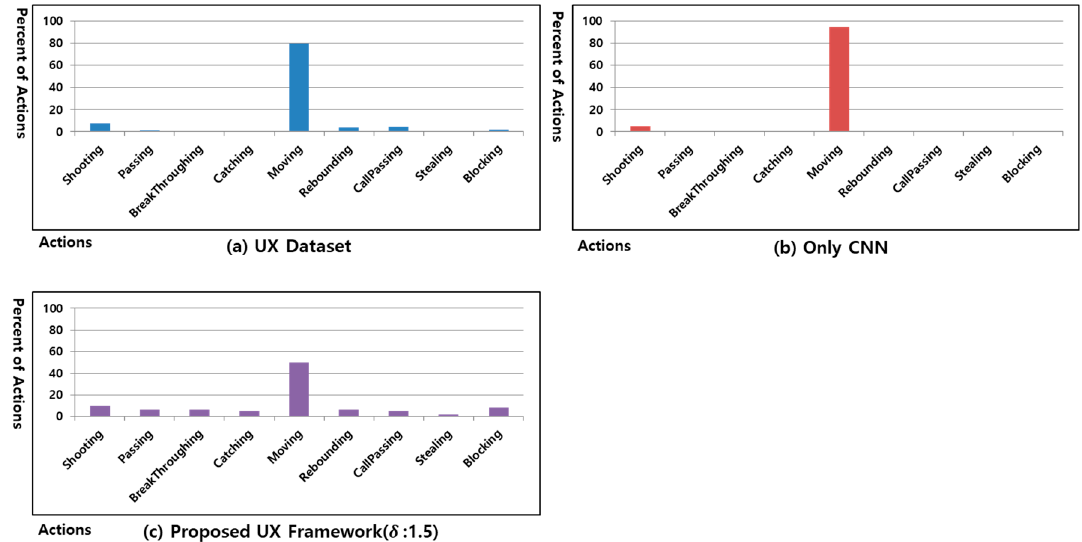
Figure 9. Percentage of actions of proposed UX framework in Freestyle game of user #2.